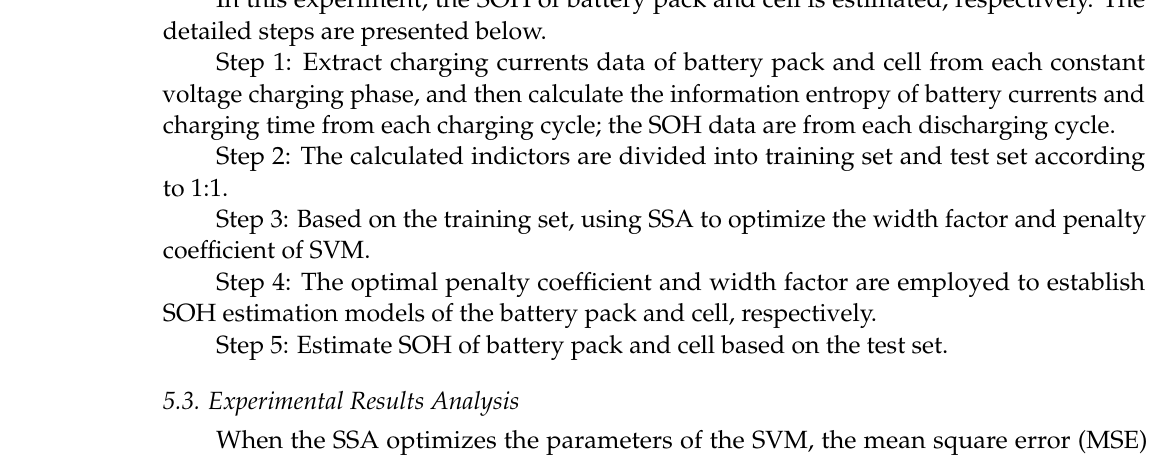
( b ) Figure 7. The estimation results of SSA-SVM. ( a ) Battery pack; ( b ) battery cell.